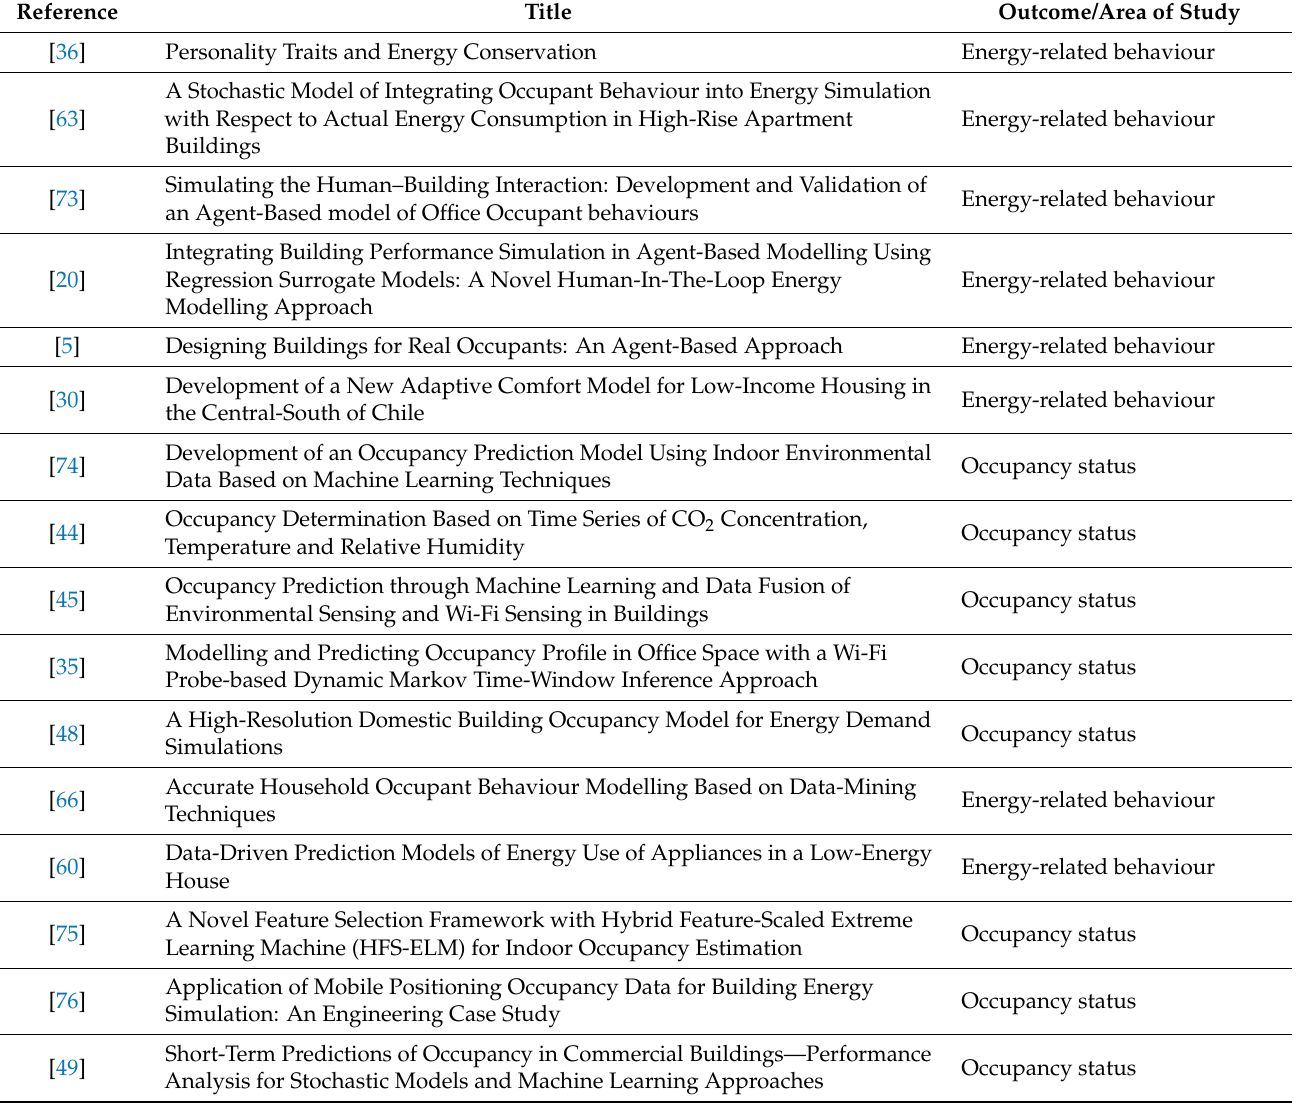
Table A1. List of Studies Used in the